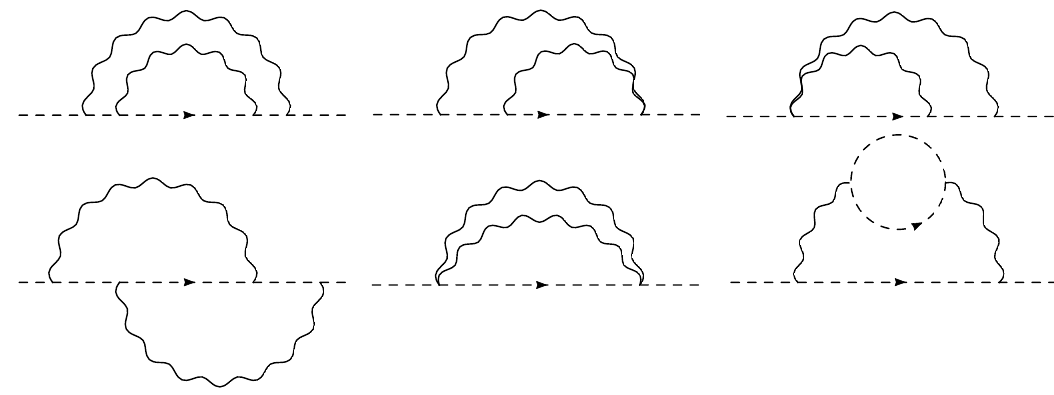
Figure 17 . One loop and two loops